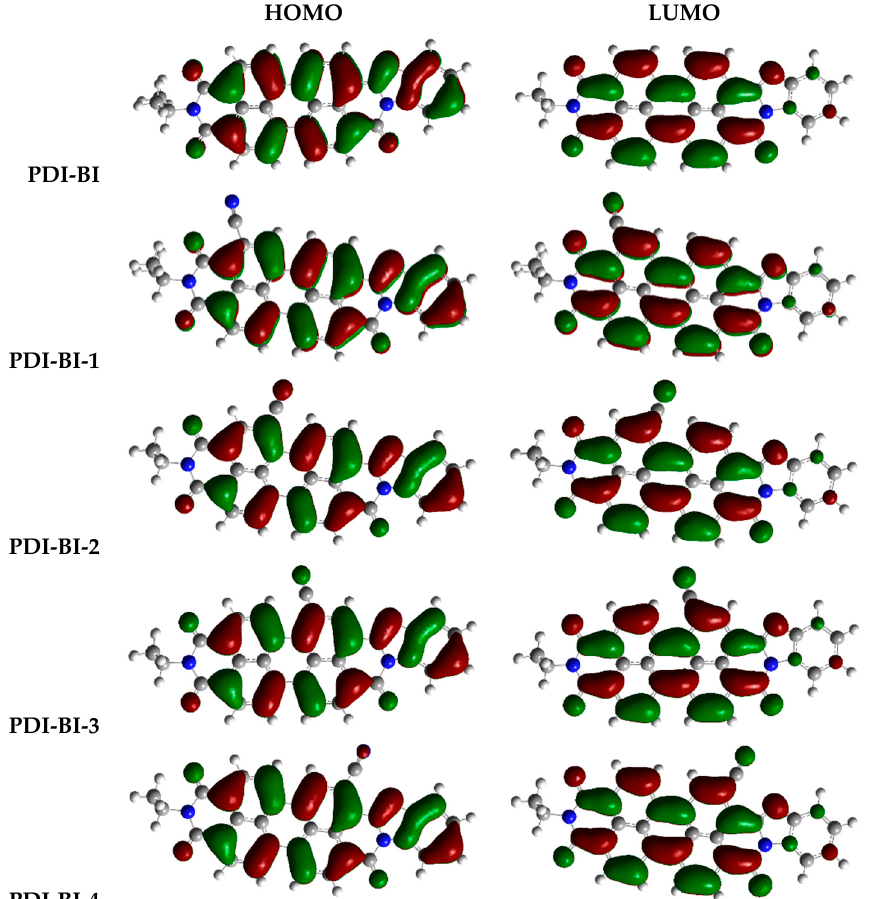
Figure 2. Cont. Figure 2.